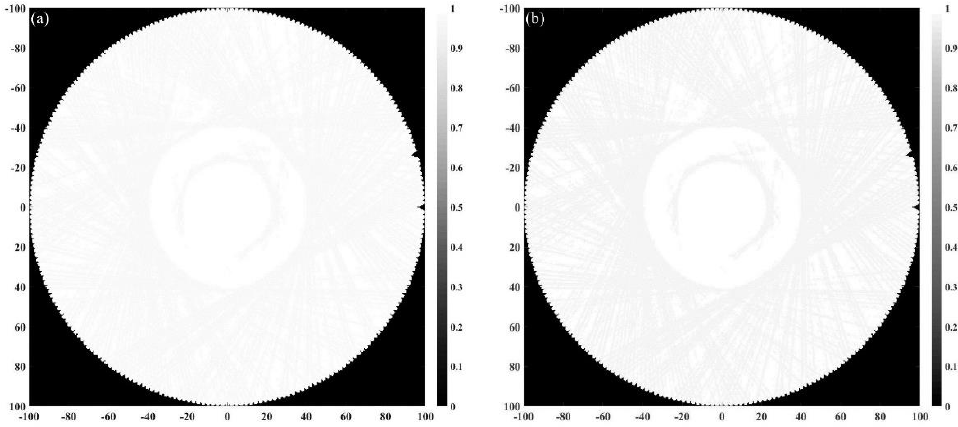
Figure 11. Reconstructed sound speed distribution. ( a ) Reconstructed through time-reversal. ( b ) Reconstructed through FBP.